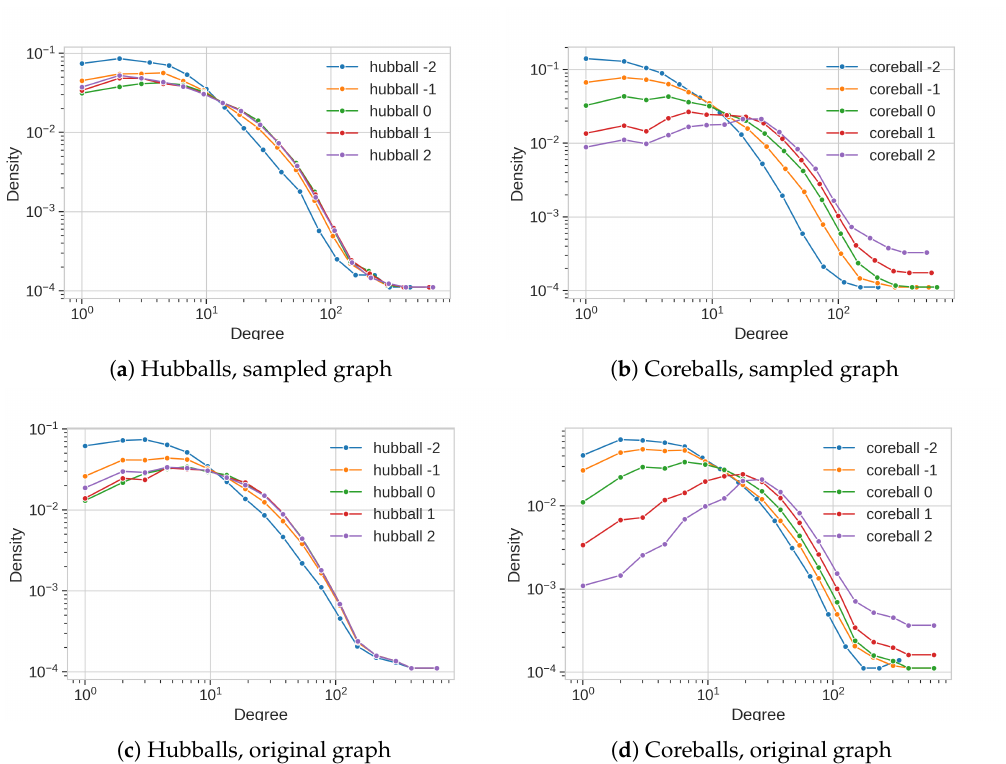
Figure 3. Degree distribution of the sampled nodes for Hubballs ( left ) and Coreballs ( right ) with different parameters, on the Facebook graph. For the sampled nodes, their degree in the sampled graph ( top ) and in the initial graph ( bottom ) lead to two different degree distributions. They are different since, in the sampled graph, edges to unsampled nodes are not present. The Hubball with α = 0 is equal to the Coreball with γ = 0, hence plots can be